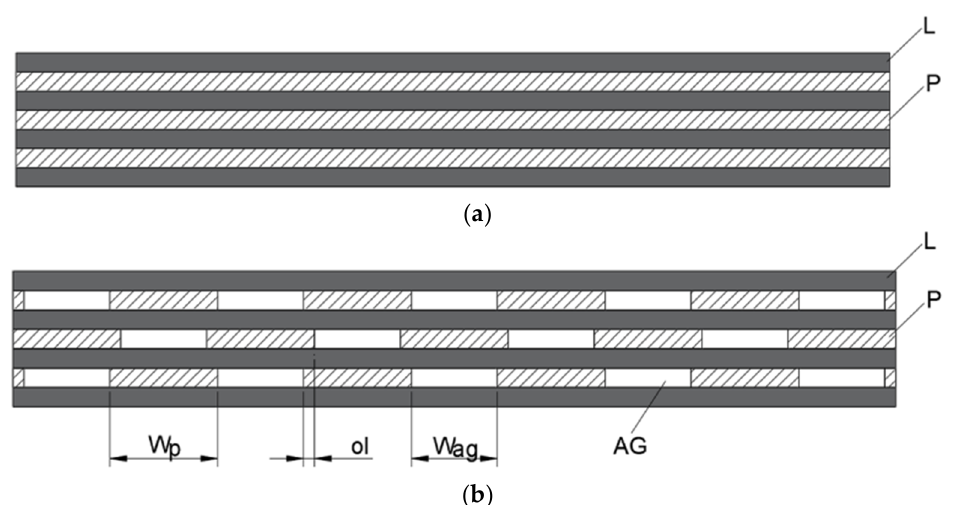
Figure 1. Construction of the plywood: ( a ) classic plywood; ( b ) lightweight plywood; L is solid ve- neer (longitudinal), i.e., the fibers are in the direction of longer dimension of the board; P is veneer strips with width W p = 160 mm (transverse veneer), i.e., the fibers are perpendicular to the fibers of solid veneer; AG is air gap; W ag is width of the air gap (100 mm); ol is overlap of the layers (30 mm), i.e., places where the veneers are joined.